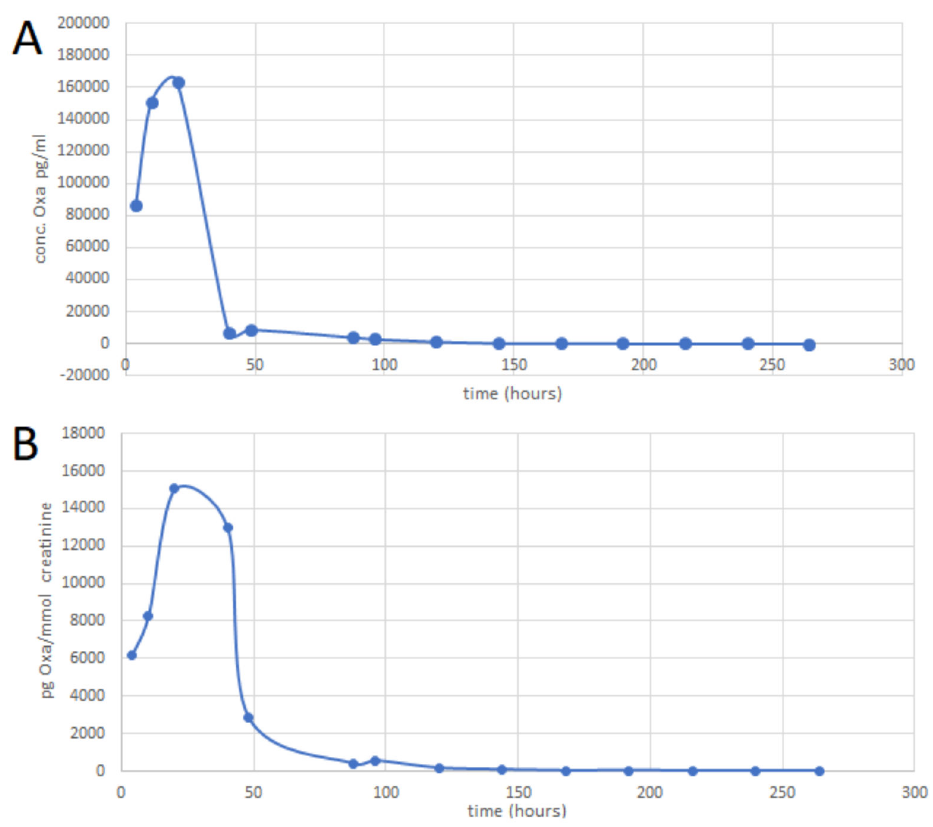
Figure 5. Time vs. concentration profiles of OXA eliminated from the body in urine. OXA was monitored in the urine samples taken from a healthy volunteer after administration of a 10 mg dose of OXA (one tablet Oxandrix). Each point in the profiles corresponds to a mean obtained from 3 consecutive measurements. ( A ) Time vs. concentration profile of OXA, ( B ) time vs. concentration profile of OXA employing quantitative OXA data normalized to creatinine.